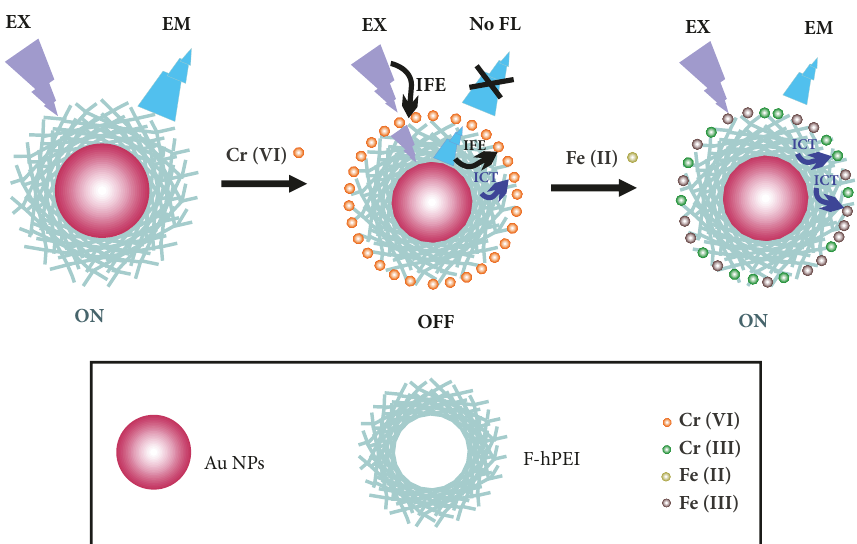
Table 1: Determination of Cr (VI) in real water samples.